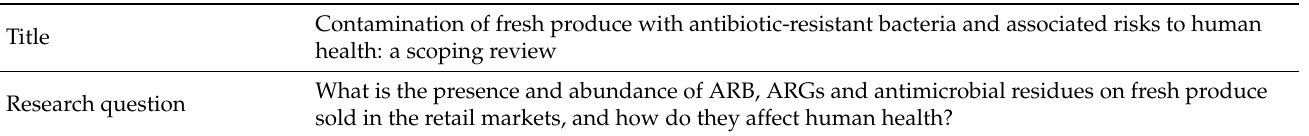
Table 1. Literature search strategy for scoping